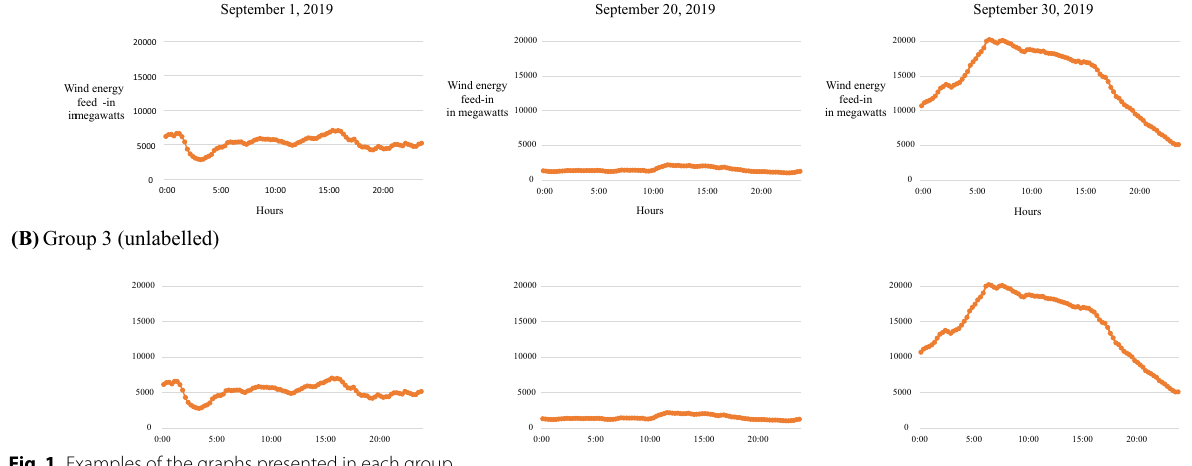
Fig. 1 Examples of the graphs presented in each